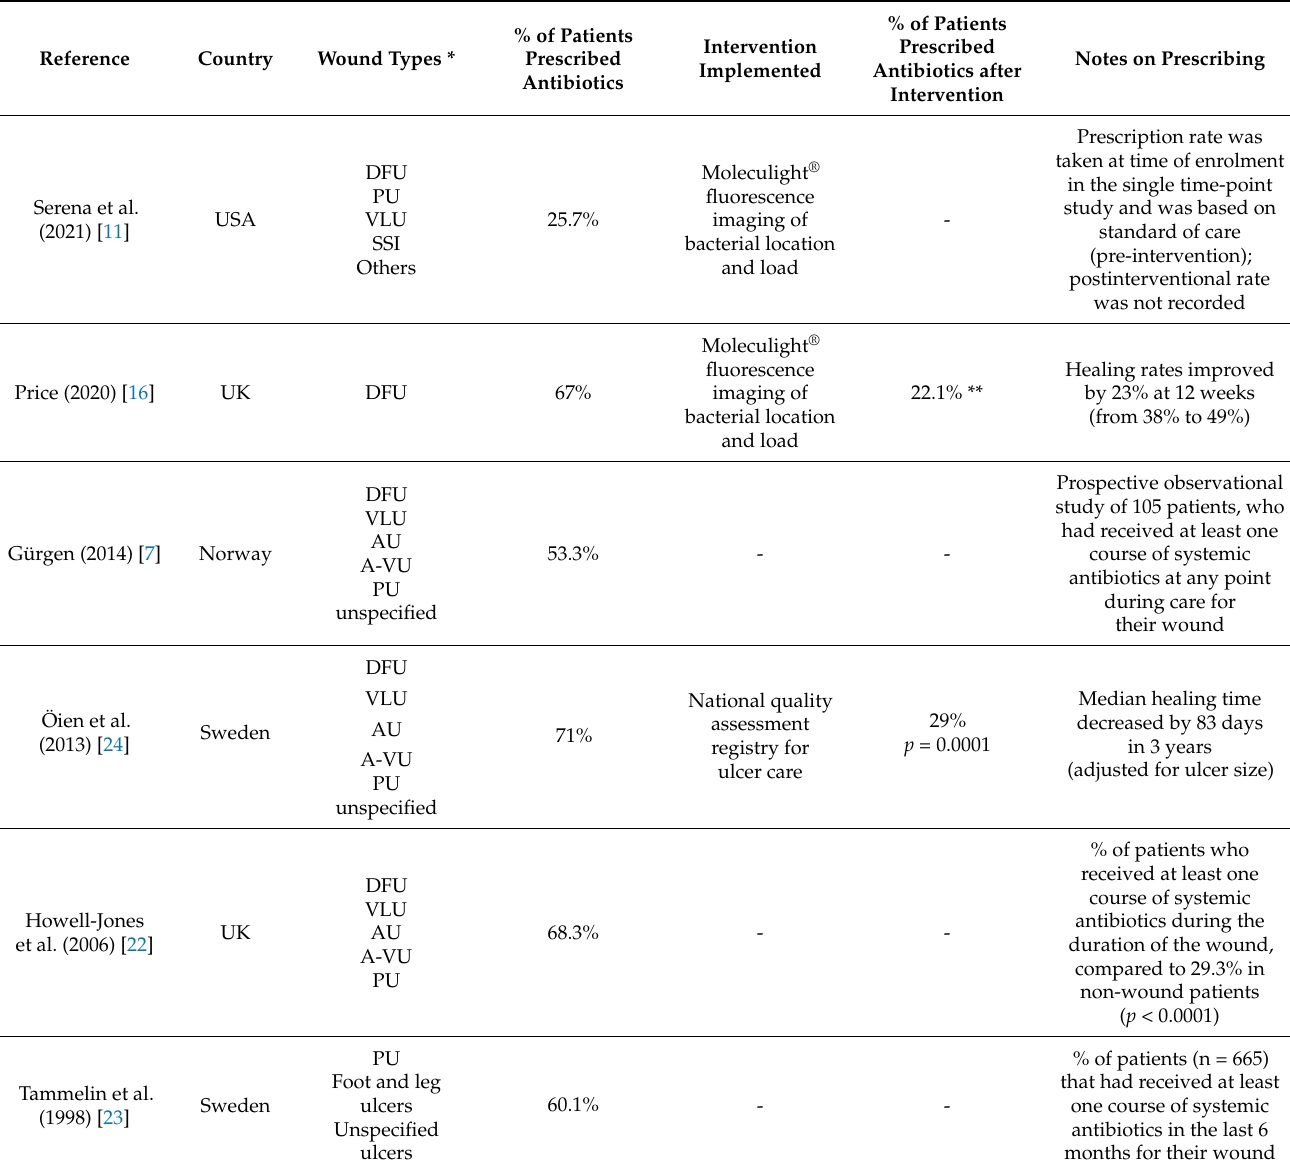
Table 1. Antibiotic prescribing rates were very high amongst wound care patients, with 53.3% to 71% of patients being prescribed a wound-related antibiotic at some point during their outpatient wound care [7,16,22–24]. Table 1. Reported systemic antibiotic prescribing rates in outpatient wound